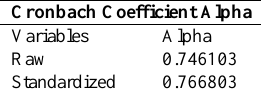
Table 4. Cronbach Coefficient